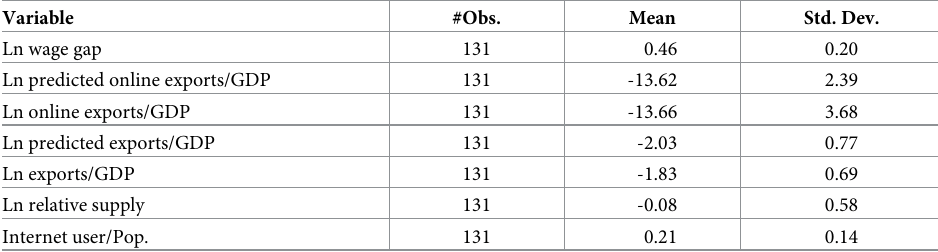
Table 2. Summary statistics.